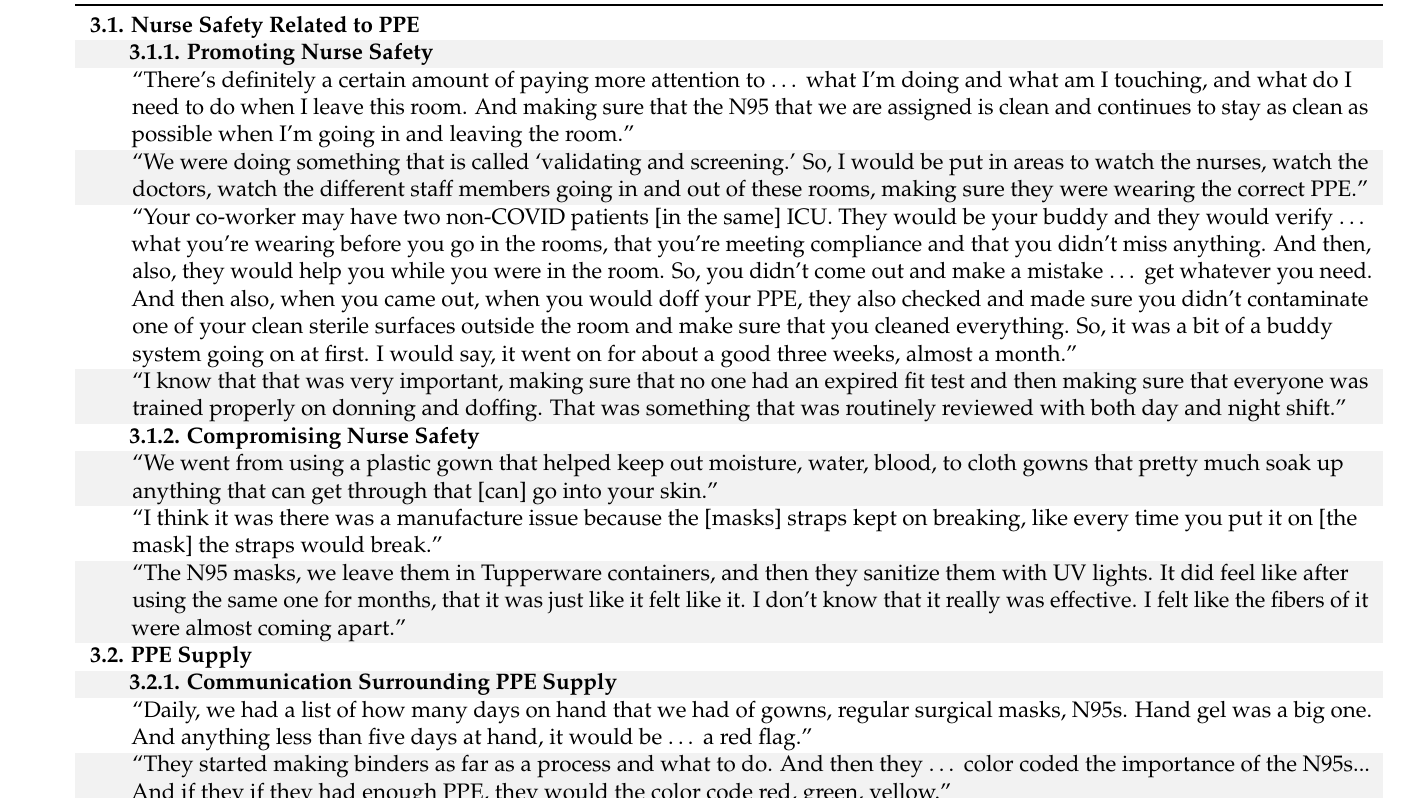
Table 2. PPE Themes and Illustrative